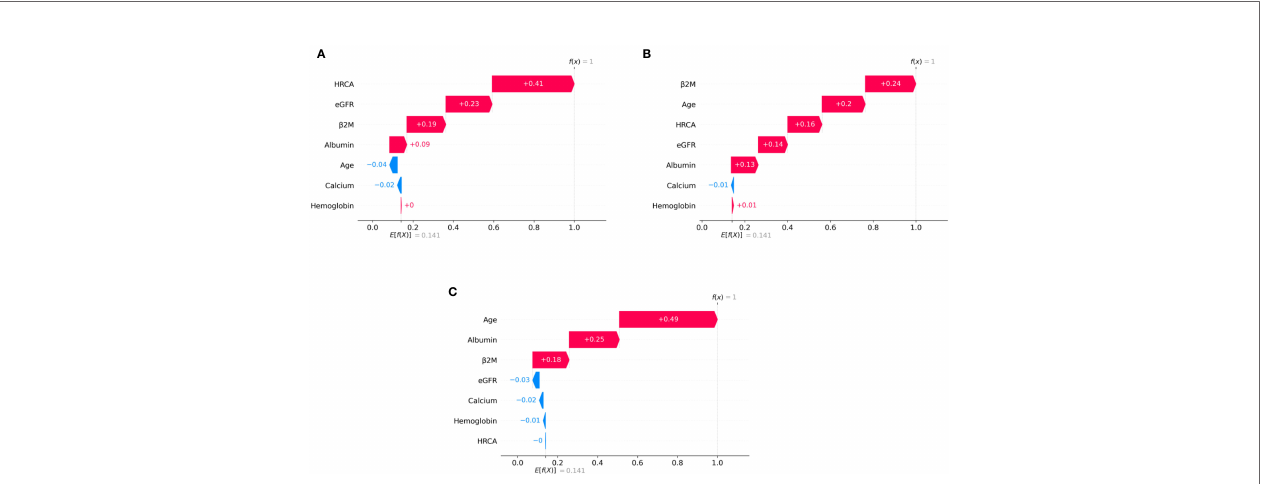
FIGURE 6 | SHAP waterfall plots for randomly chosen patients in high-risk stage (CRSS-3) from the MMIn dataset. The pink color shows the positive impact of the feature, while the blue color shows the negative impact of the feature. Features with a positive impact contributed to the class of high-risk stage prediction, while features with a negative impact contributed to class opposite to highest risk. HRCA, b 2M, age, and albumin have the highest overall impact on high-risk stage prediction. However, this ranking differs from patient to patient as can be seen in (A – C) . (A) HRCA has the highest impact. (B) b 2M has the highest impact. (C, D) Age and albumin have the highest